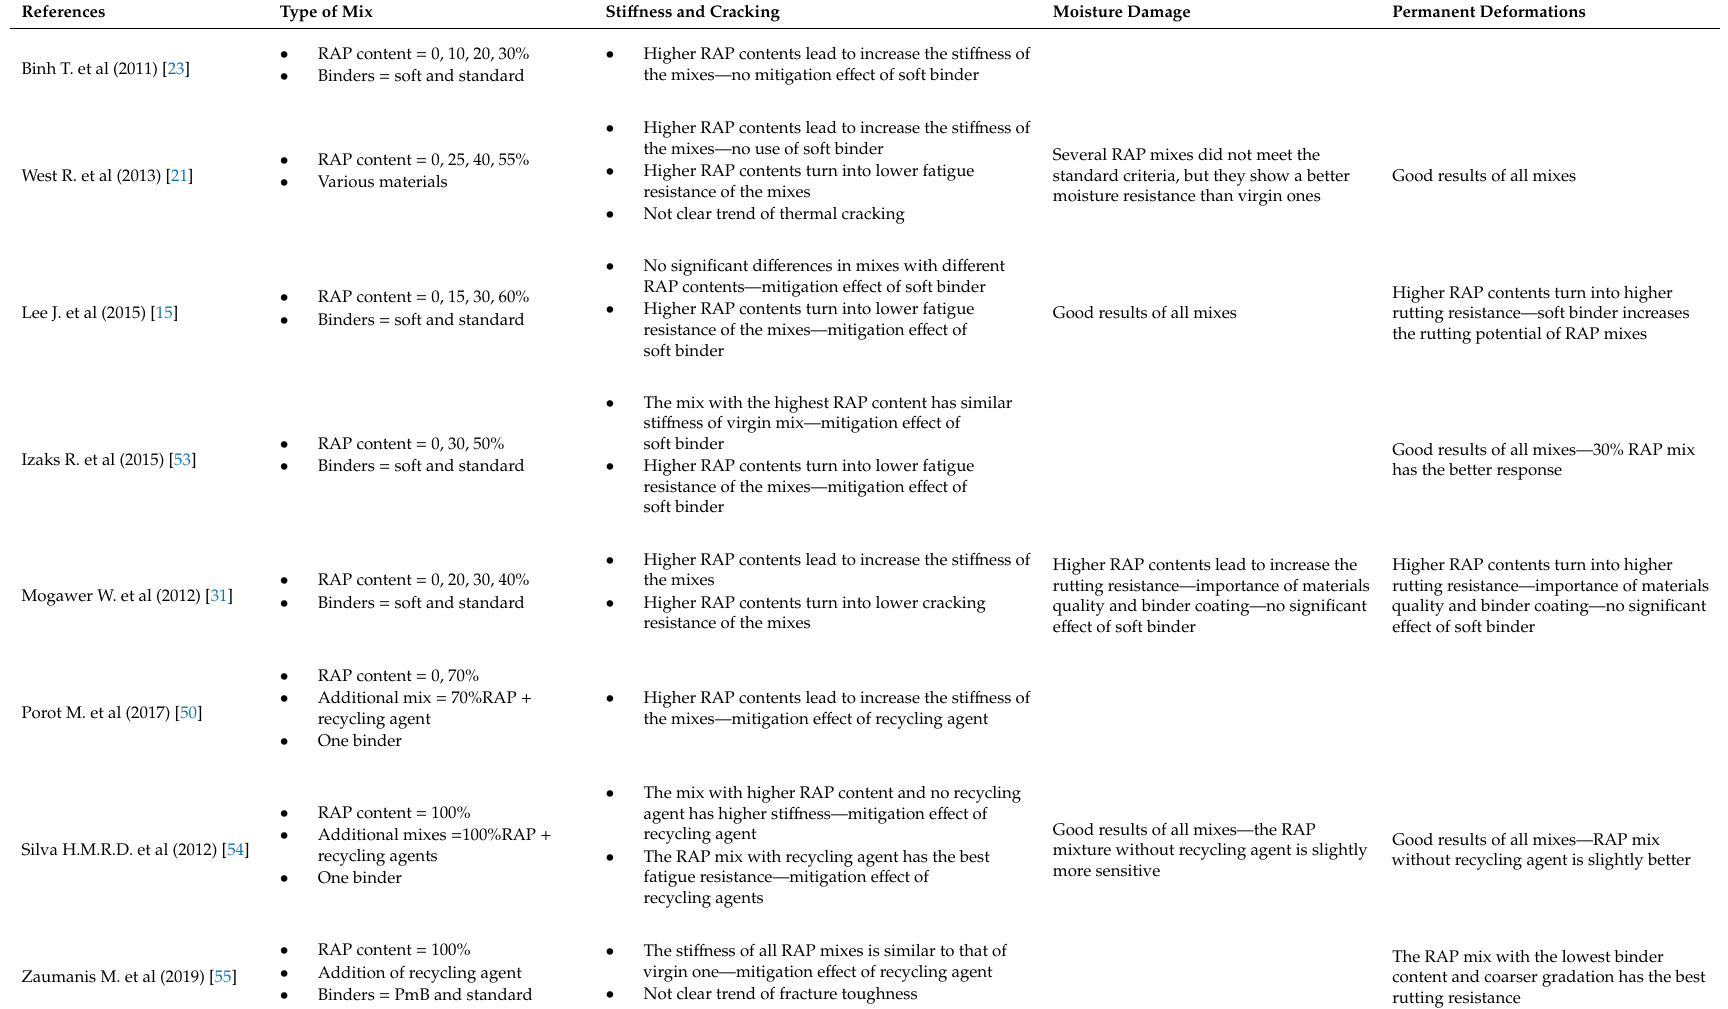
Table 4. Performances of asphalt mixtures with low, high and very high content of